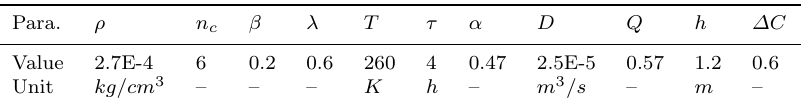
Table 2. The input values and units of main parameters.